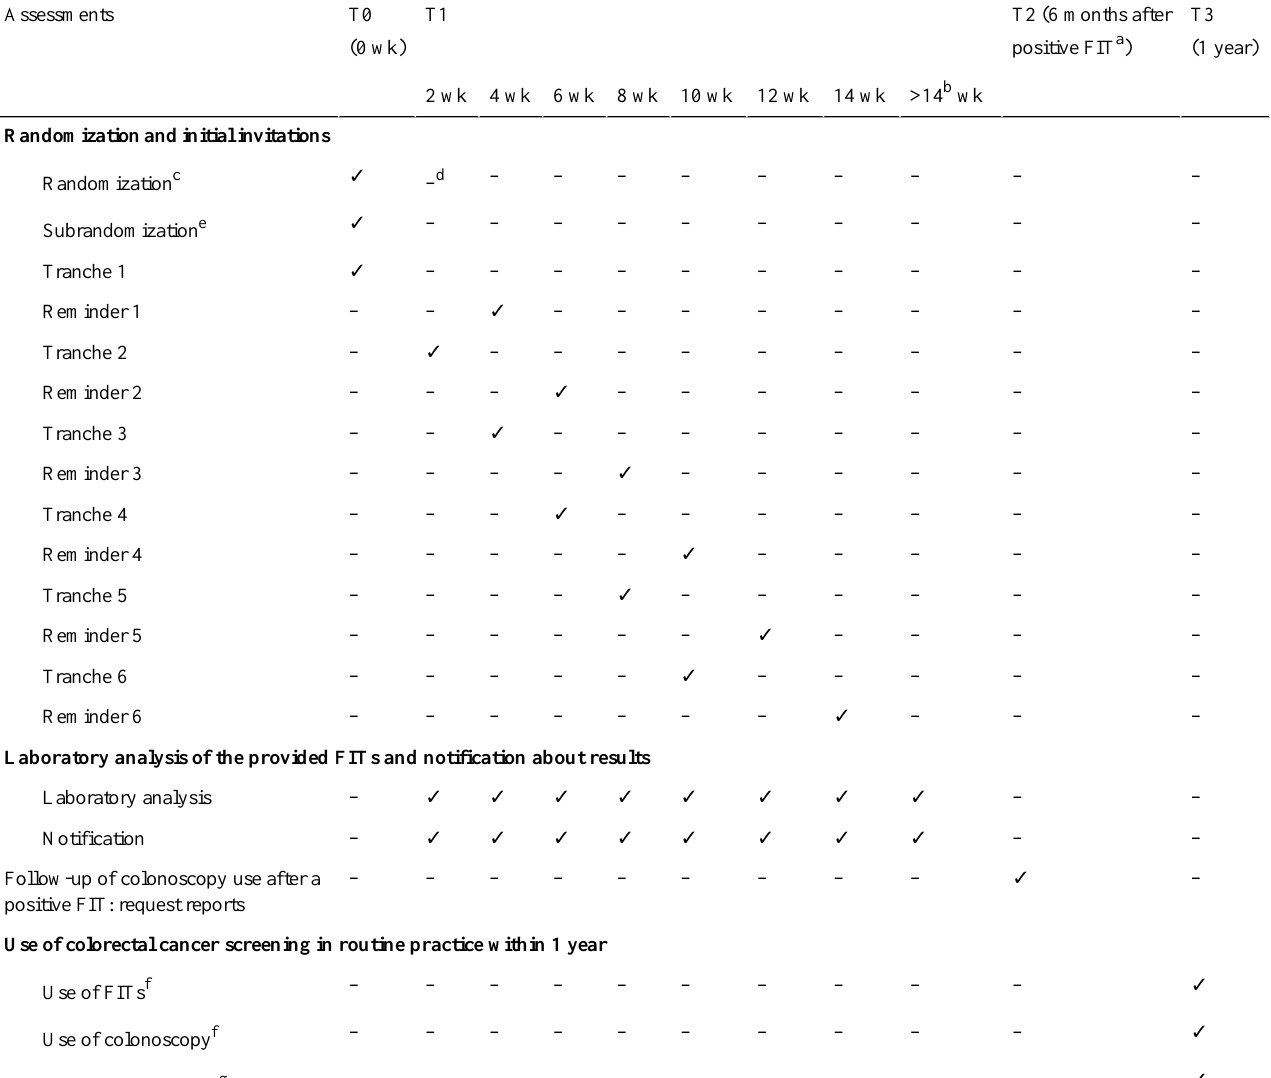
Table 1. Overview of study assessments at relevant time points.